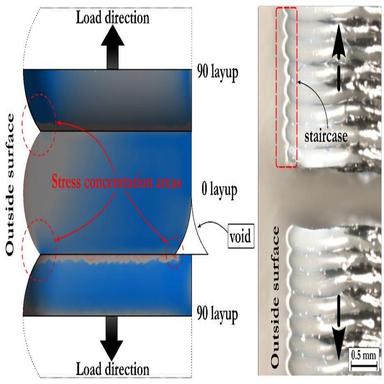
Mesostructure of the vertical printed sample (XZ) showing stress concentration areas on the left and optical microscopical image of the fractured specimen on the right.